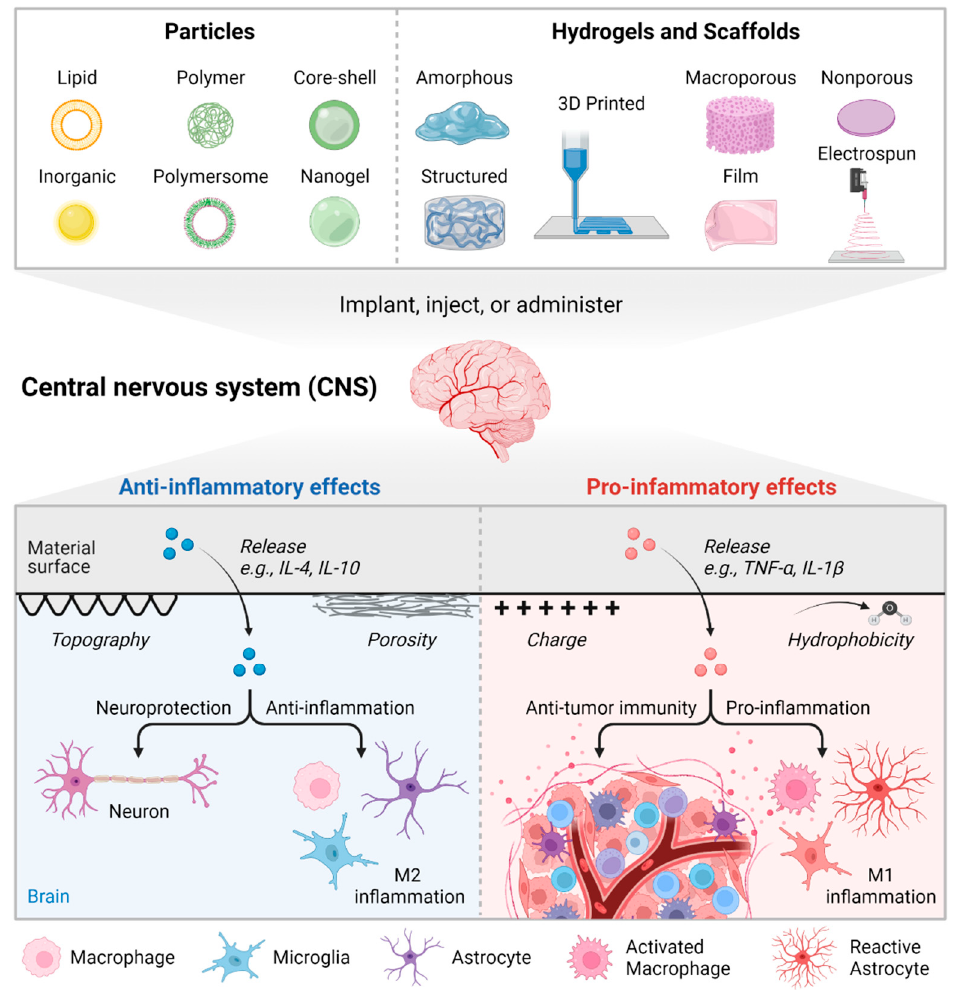
Figure 1. Overview of engineering material properties to instruct inflammatory outcomes. Created with Biorender.com and exported under a paid